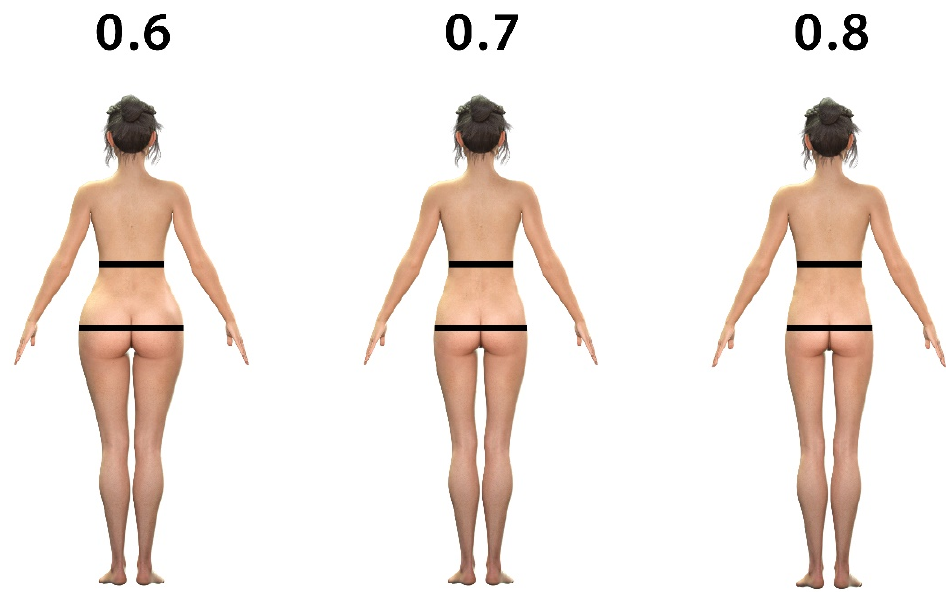
Figure 5. Generated WHR models for the survey. The black bars on the 3D images show the measurement points for the WHR. Table 3. Comparison between Instagram fitness influencer WHRs and the participants’ favored WHRs. Germany Nigeria USA Japan p